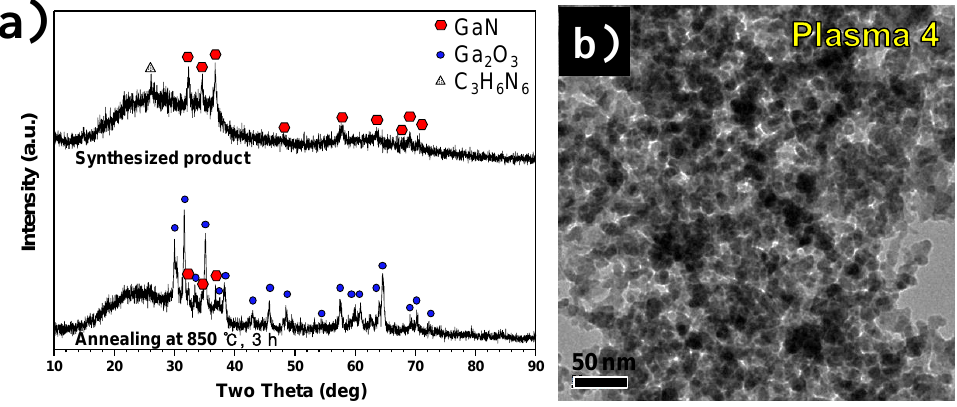
Figure 11. ( a ) XRD patterns before and after annealing and ( b ) FE-TEM image of unannealed product from a Ga(NO 3 ) 3 ∙32H 2 O pellet and C 3 H 6 N 6 powder injection with NH 3 gas by the thermal plasma process in Plasma 4.